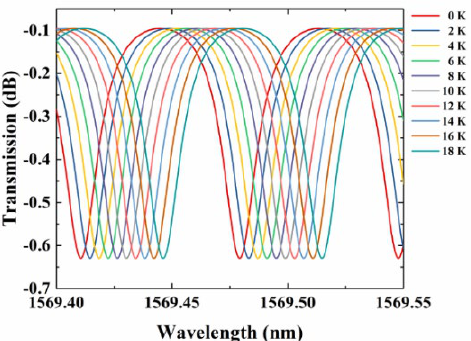
Figure 3. Calculated normalized transmission with resonant wavelength tuning of tunable MRR.